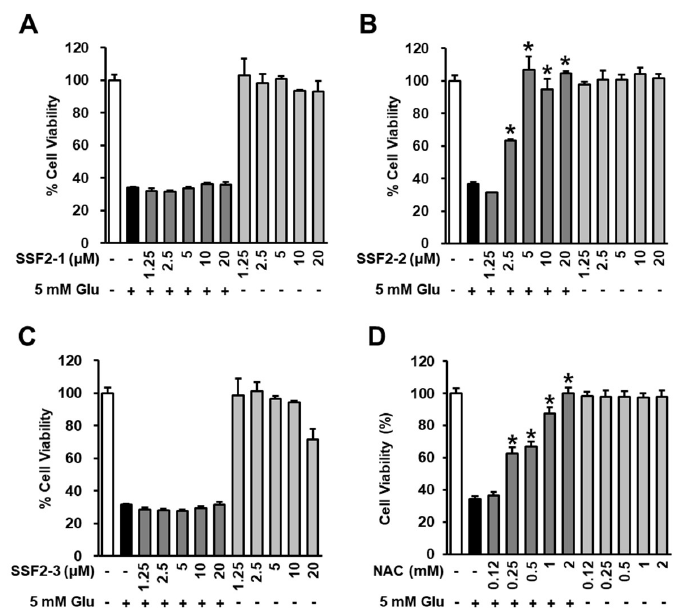
Figure 2. Effects of SSF2-1, SSF2-2, and SSF2-3 on cell viability after glutamate treatment. HT22 cells were incubated for 24 h with 5 mM glutamate (Glu) with or without ( A ) SSF2-1, ( B ) SSF2-2, ( C ) SSF2-3, and ( D ) N-acetylcysteine (NAC) at various concentrations. Cell viability was assessed using the Ez-CyTox reagent. Data represent the mean ± S.E.M., n = 3, * p < 0.05 compared with the glutamate-treated control.